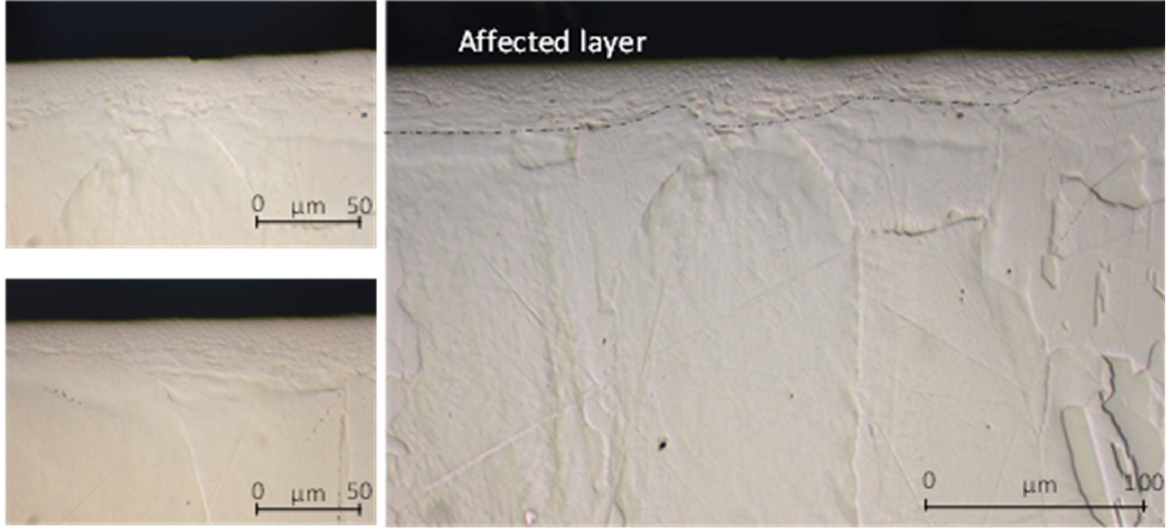
Figure 10. Micrographs of the part surface after a pin-on-disk test under LIL condition: 1000-m test.